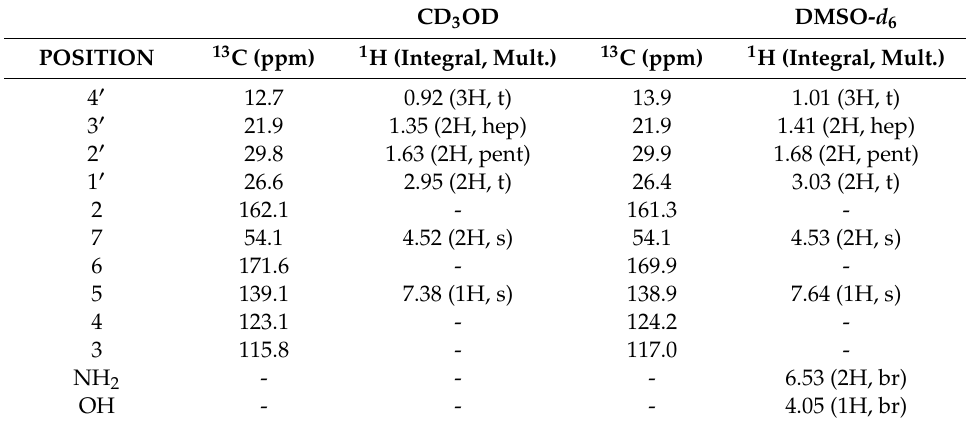
Table 1. NMR data of AHFA 1 in CD 3 OD and DMSO- d 6 at 600 MHz and 298